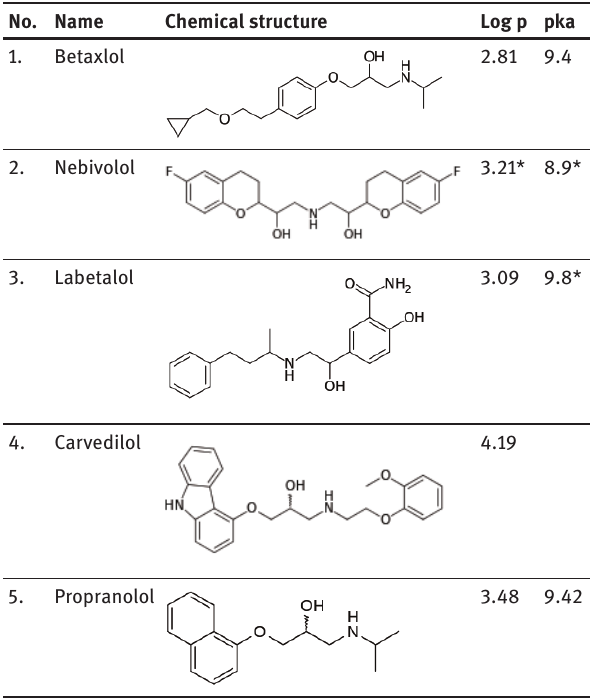
Table 1: Chemical structures, log ß-adrenergic